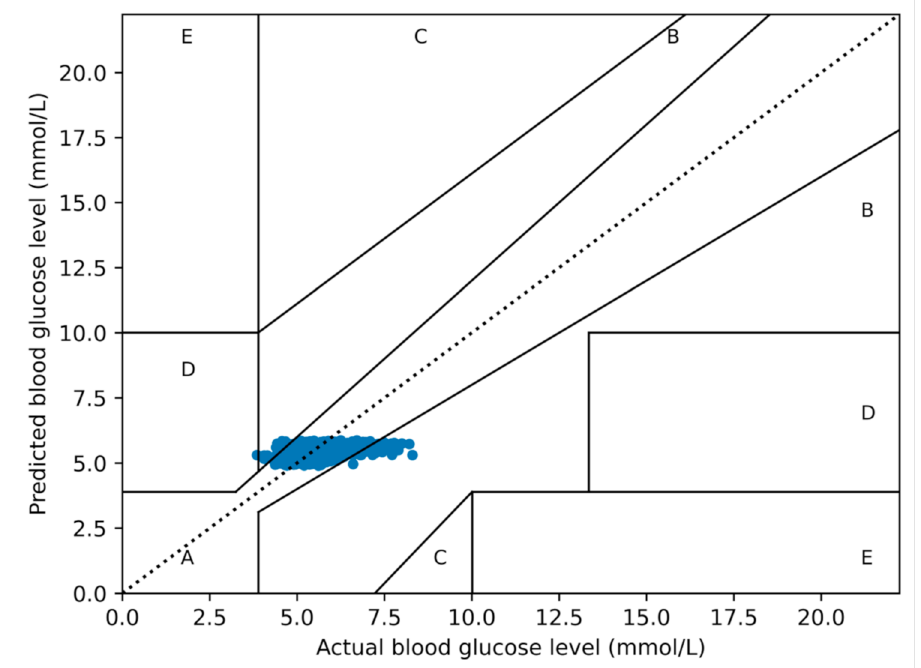
Figure 12. The EGA diagram for the RG_GBDT model.